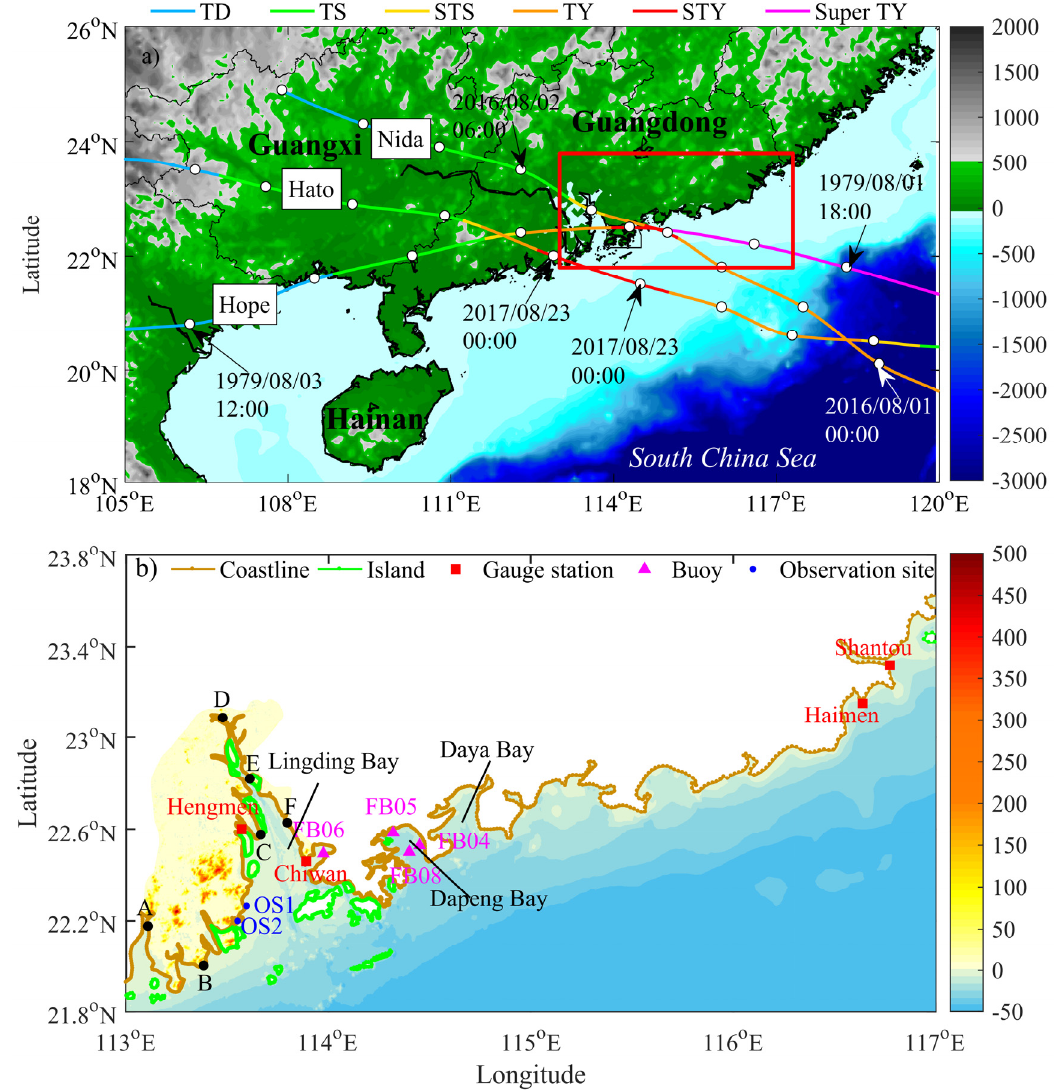
Figure4. Thetopography(units: m; shaded)ofcomputationaldomainsuitablefortheADCIRC + SWAN Figure 4. The topography (units: m; shaded) of computational domain suitable for the ADCIRC + 206 coupled model. ( a ) Three typhoon paths are plotted in ( a ) by rainbow lines to show the typhoon SWAN coupled model. ( a ) Three typhoon paths are plotted in Figure 4a by rainbow lines to show the 207 wind scale (CMA). ( b ) The ( b ) shows the area corresponding that circled by the red box in the ( a ). typhoon wind scale (CMA). ( b ) The Figure 4b shows the area corresponding that circled by the red 208 The topography (units: m; shaded) shown in the ( b ) represents elevation of the PRE within the mesh in box in the Figure 4a. The topography (units: m; shaded) shown in the Figure 4b represents elevation 209 Figure 2a. The gauge stations, buoys, and observation sites mentioned in this paper are marked in of the PRE within the mesh in Figure 2a. The gauge stations, buoys, and observation sites mentioned 210 ( b ). The typhoon scale represented by the letters in the figure are as follows: TD: Tropical depression; in this paper are marked in Figure 4b. The typhoon scale represented by the letters in the figure are as 211 TS: Tropical storm; STS: Strong tropical storm; TY: Typhoon; STY: Strong typhoon; Super TY: Super follows: TD: Tropical depression; TS: Tropical storm; STS: Strong tropical storm; TY: Typhoon; STY: 212 typhoon. The black dots in ( b ) represent places at the PRE, A: Yamen; B: Jinwan Airport; C: Nansha; D: Huangpu; E: Humen; F: Shenzhen Strong typhoon; Super TY: Super typhoon. The black dots in Figure 4b represent places at the PRE, 213 A: Yamen; B: Jinwan Airport; C: Nansha; D: Huangpu; E: Humen; F: Shenzhen Airport. 214